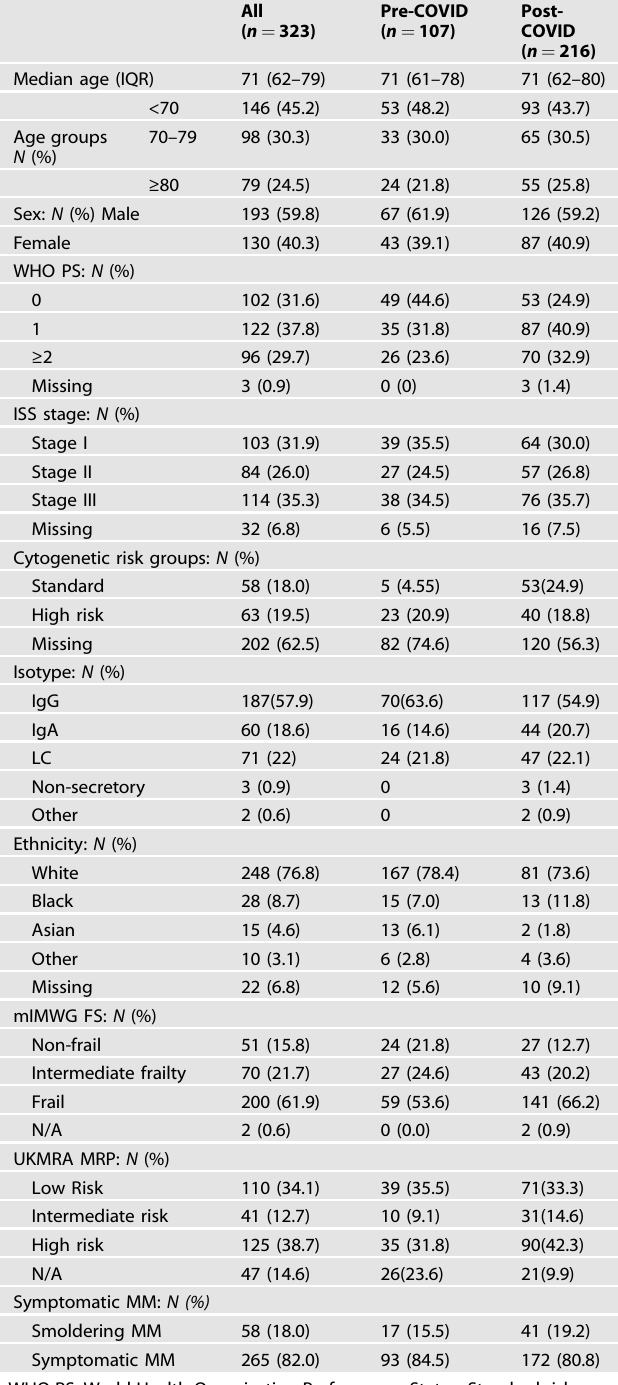
Table 1. Baseline patient characteristics of all ( n = 323) those diagnosed from 01 January 2019 – 31 January 2020 (Pre-COVID, n = 110) and those diagnosed from 01 February 2020 – 31 July 2021 (Post-COVID, n =